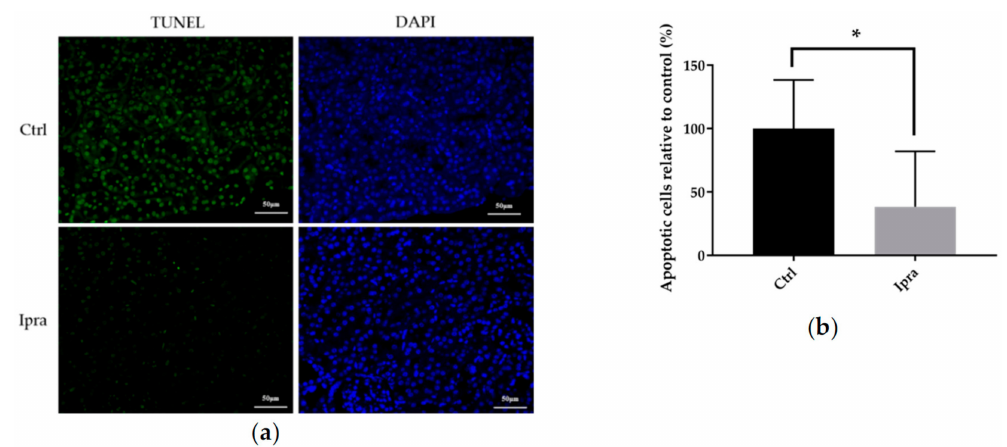
Figure 7. E ff ect of ipragliflozin on renal cellular apoptosis in FLS- ob / ob mice. ( a ) Representative images of TUNEL staining on FLS- ob / ob mouse kidney para ffi n-embedded sections. ( b ) Quantification of apoptotic cells. The percentage of TUNEL positive cells to DAPI positive cells was expressed as relative level to control group. The quantification is based on randomly captured three fields from six di ff erent mice in each group. Bars indicate average ± SEM. * p < 0.05 (unpaired t -test). TUNEL, terminal deoxynucleotidyl transferase dUTP nick end labeling; DAPI, 4 (cid:48) ,6-diamidino-2-phenylindole; Ctrl, control group; Ipra, ipragliflozin